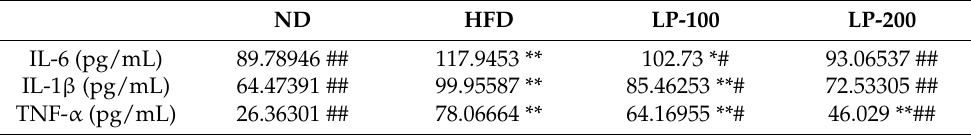
Table 5. Effect of PSCP on the levels of renal IL-1 β , IL-6, and TNF- α in the HFD-fed mice.